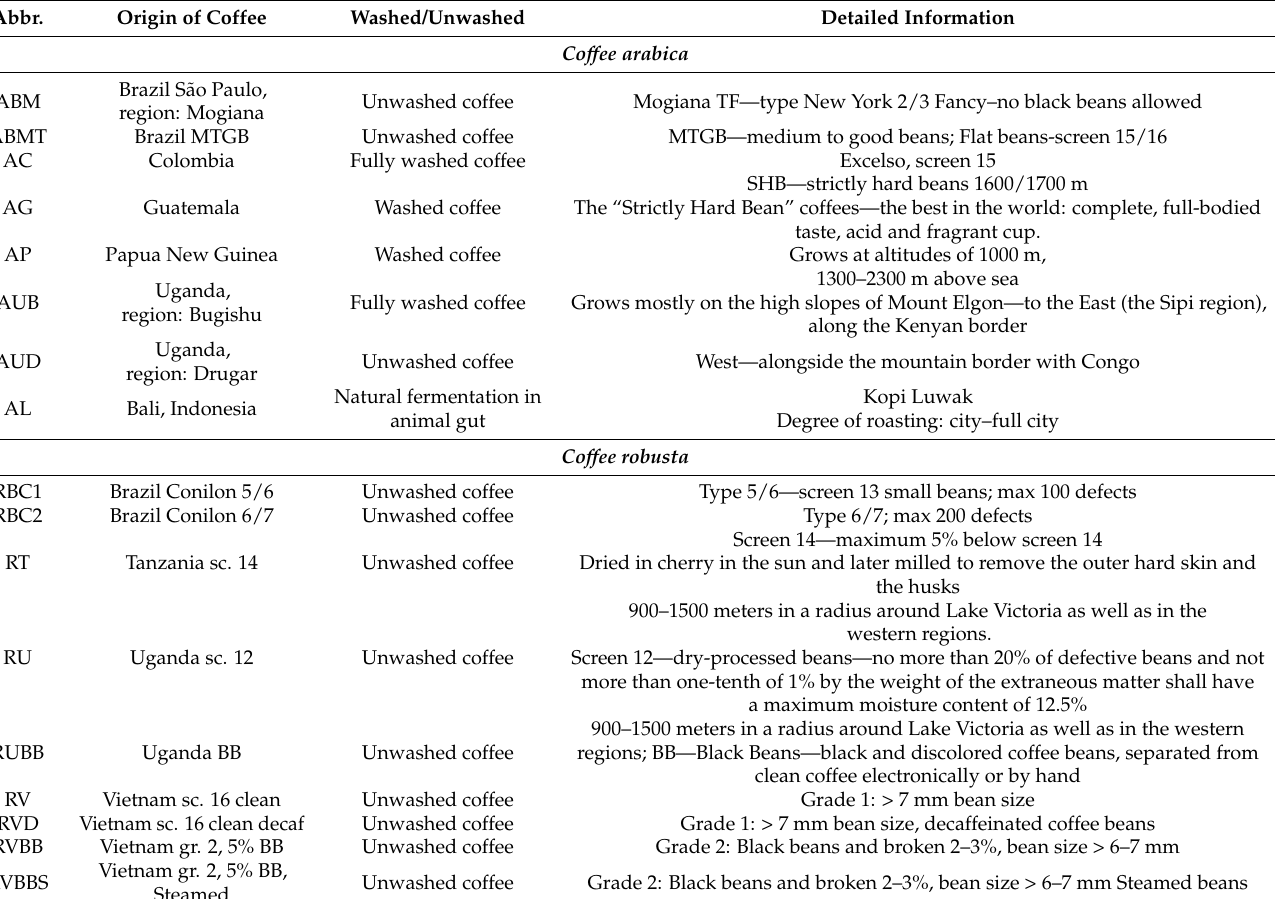
Table 1. Abbreviations, origins, and detailed information of Coffea arabica and C. robusta